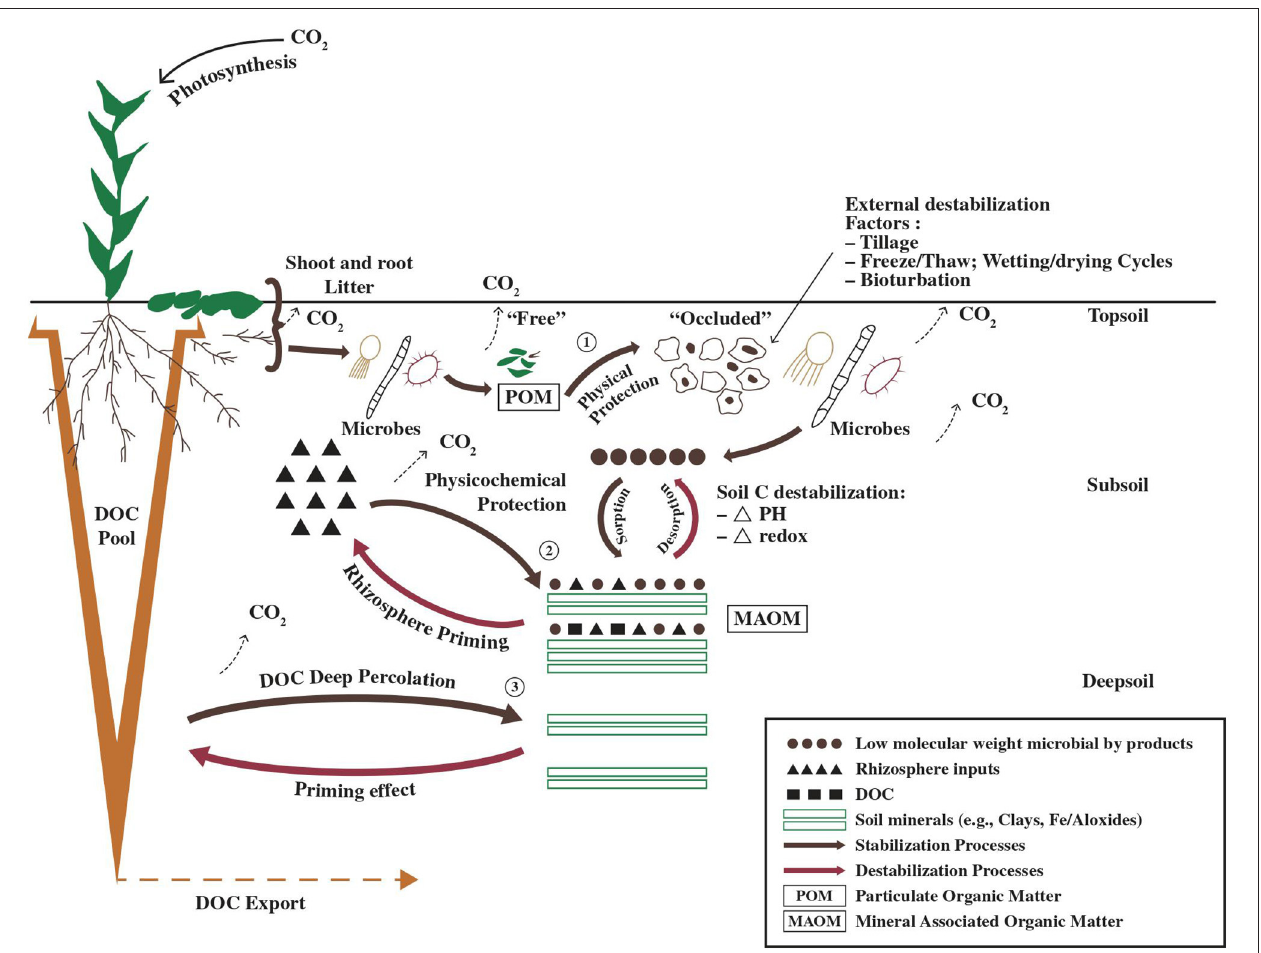
FIGURE 1 | Summary of the main mechanisms of soil organic carbon stabilization/destabilization. (1) Physical protection, (2) Physicochemical protection, (3) DOC deep percolation.